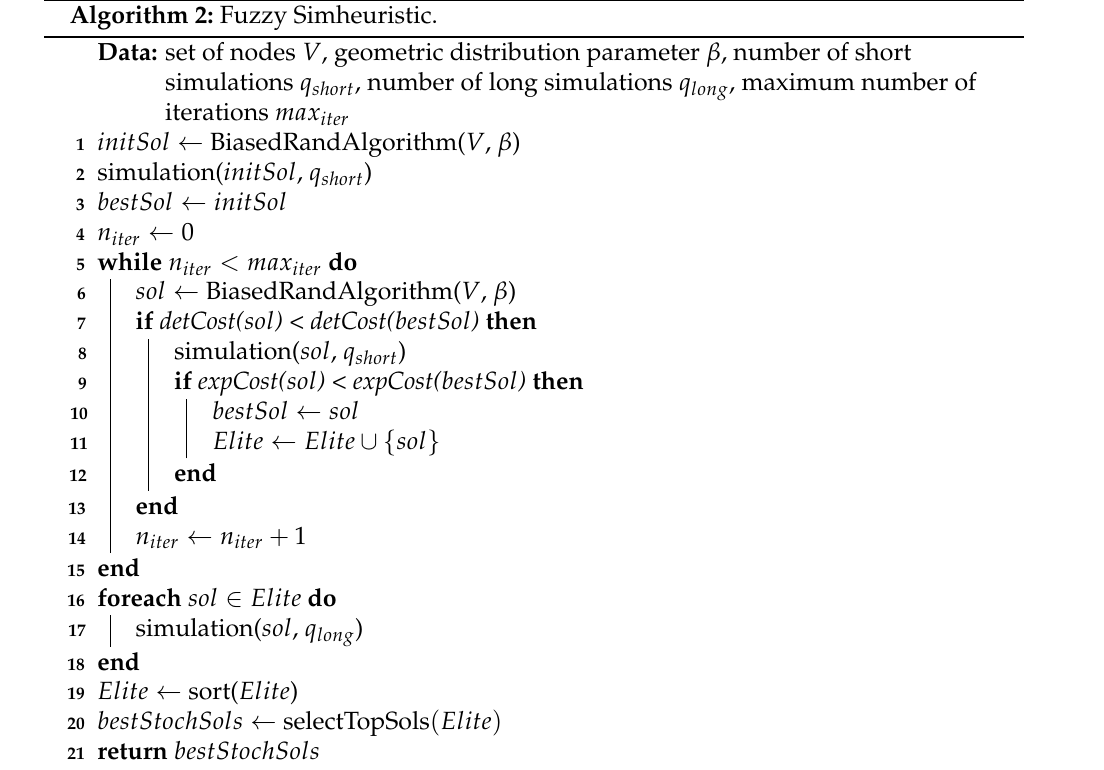
Algorithm 2: Fuzzy